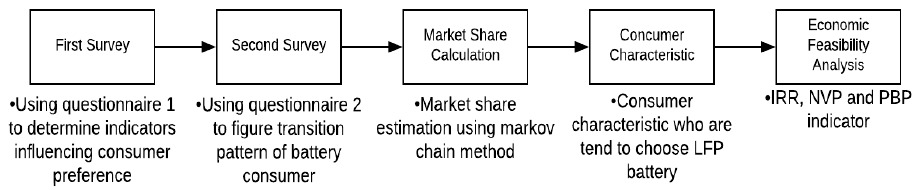
Figure 1. Research Figure 1. Research Method.